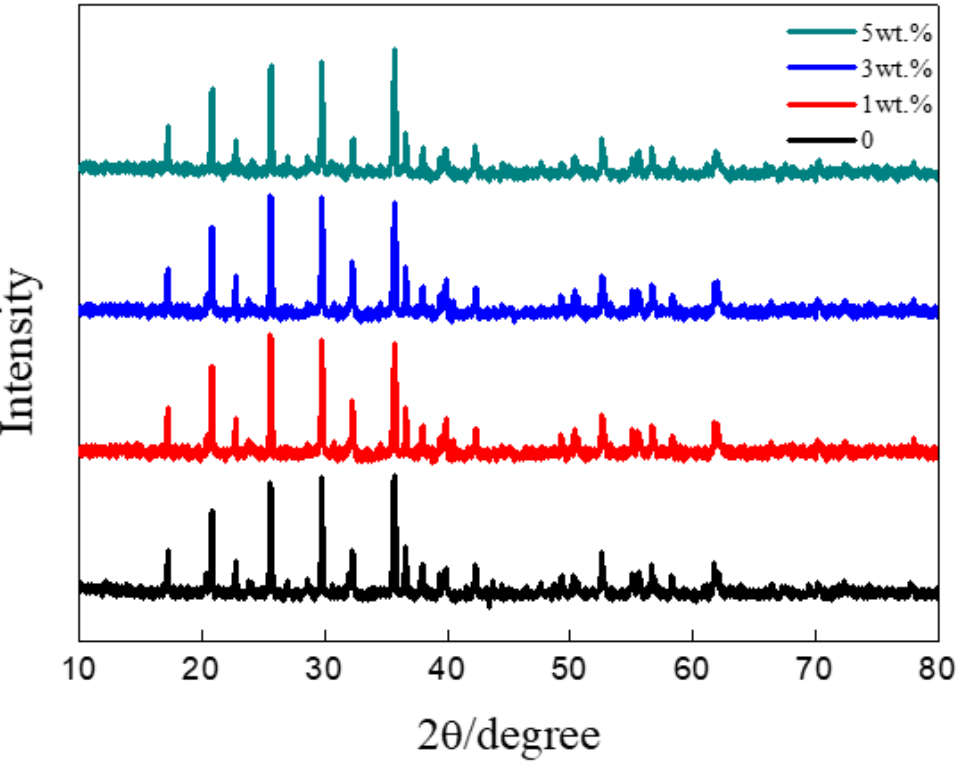
Figure 1. XRD patterns of LiFePO 4 /C-xZnO products with x = 0, 1 wt%, 3 wt%, and 5 wt%.